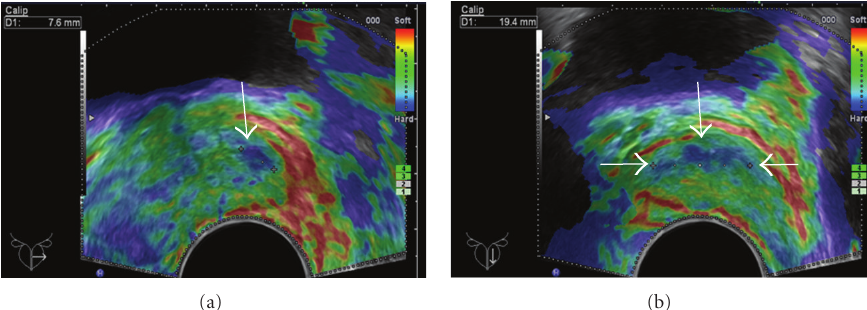
Figure 1: Hard area PZ mid-gland left measured with 7.6 mm in the axial plane ((a), white arrow) and with 19.4 mm in the sagittal plane ((b), white